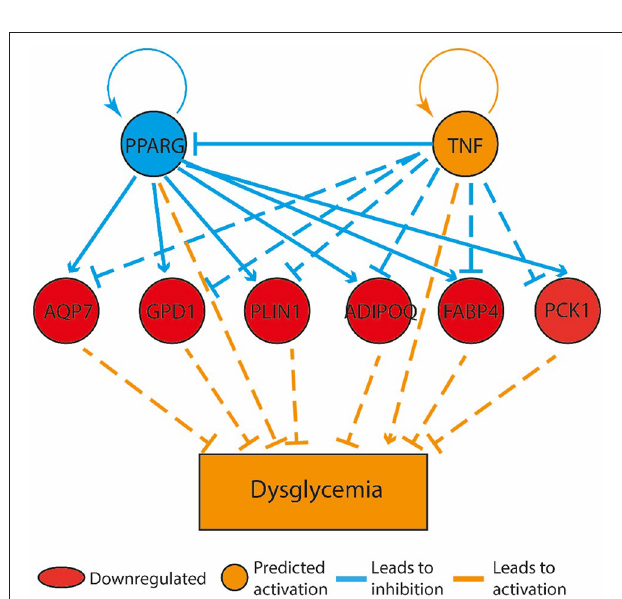
FIGURE 5 | Bone marrow gene expression retained a memory of physical activity following 60 days of physical activity cessation. The top tier consists of predicted upstream regulators that might explain the gene expression changes observed in the experiment. PPARG and TNF are the upstream regulators whose predicted states may explain the altered regulation of the middle tier genes. The observed gene expression changes lead to a predicted increase in “dysglycemia” (bottom